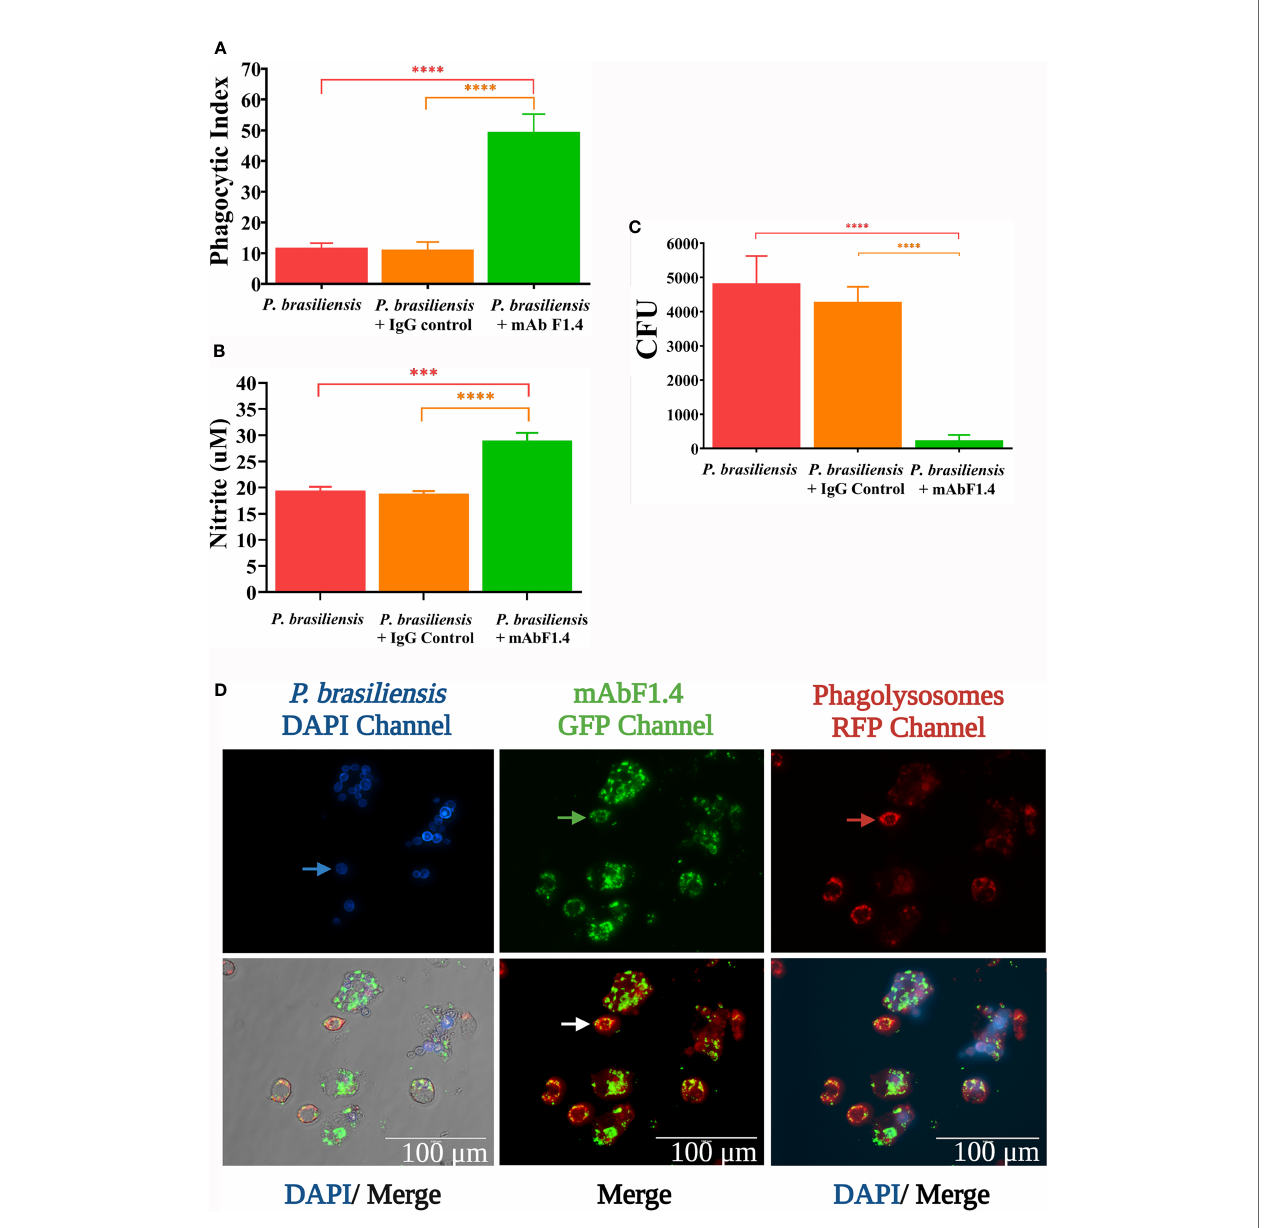
FIGURE 2 | Phagocytosis assays performed with J774.1A cell line macrophages challenged with P. brasiliensis (Pb18) with or without opsonization with mAbF1.4 or the IgG control mAb. Bars depict means and SEMs of three independent experiments, with wells performed in triplicate. Overall differences in the variance of all treatments were assessed for signi fi cance by repeated-measures one-way ANOVA with results of Tukey ’ s post hoc test for multiple comparisons displayed in the graph. ****P < 0.0001. (A) Phagocytic index assessed as PI=P*F . Where P is the percentage of macrophages with internalized yeasts and F the average of phagocyted yeast cells, counted by light microscopy at 400X magni fi cation. Experiments were performed in triplicate and different fi elds were counted until 1000 cells were checked. (B) NO determination as by Griess reaction, assessed as the nitrite present in the culture supernatant of challenged macrophages. Calibration curves were performed using NaNO 2 standard solutions (1,5625 - 100 µM). Absorbance was determined at 550 nm. (C) Killing effect determined by the viability of the phagocyted yeasts by plating the content of the macrophages after hypotonic lysis with sterile distillated H 2 O on BHI supplemented agar. CFU were counted after 21 days of incubation at 37°C. (D) Phagocytosis assay visualized by immuno fl uorescence. P. brasiliensis yeasts were stained with Calco fl uor White, visible in the DAPI channel. The blue arrow points out non- opsonized/non- internalized yeasts. The formation of antigen- antibody complexes were revealed with an anti- mouse IgG labeled with Alexa Fluor 488 nm and observed in the GFP channel. The green arrow points out opsonized/internalized yeasts. Lysosome labeling was used to evaluate formation of phagolysosomes within live macrophage cells and were visualized in the RFP channel. The red arrow shows macrophage lysosomes. In the merge images the channels were overlayed to integrate the information. The photomicrographs were obtained in a EVOS fl uorescence microscope at 100X, scale bars are shown. ***p: